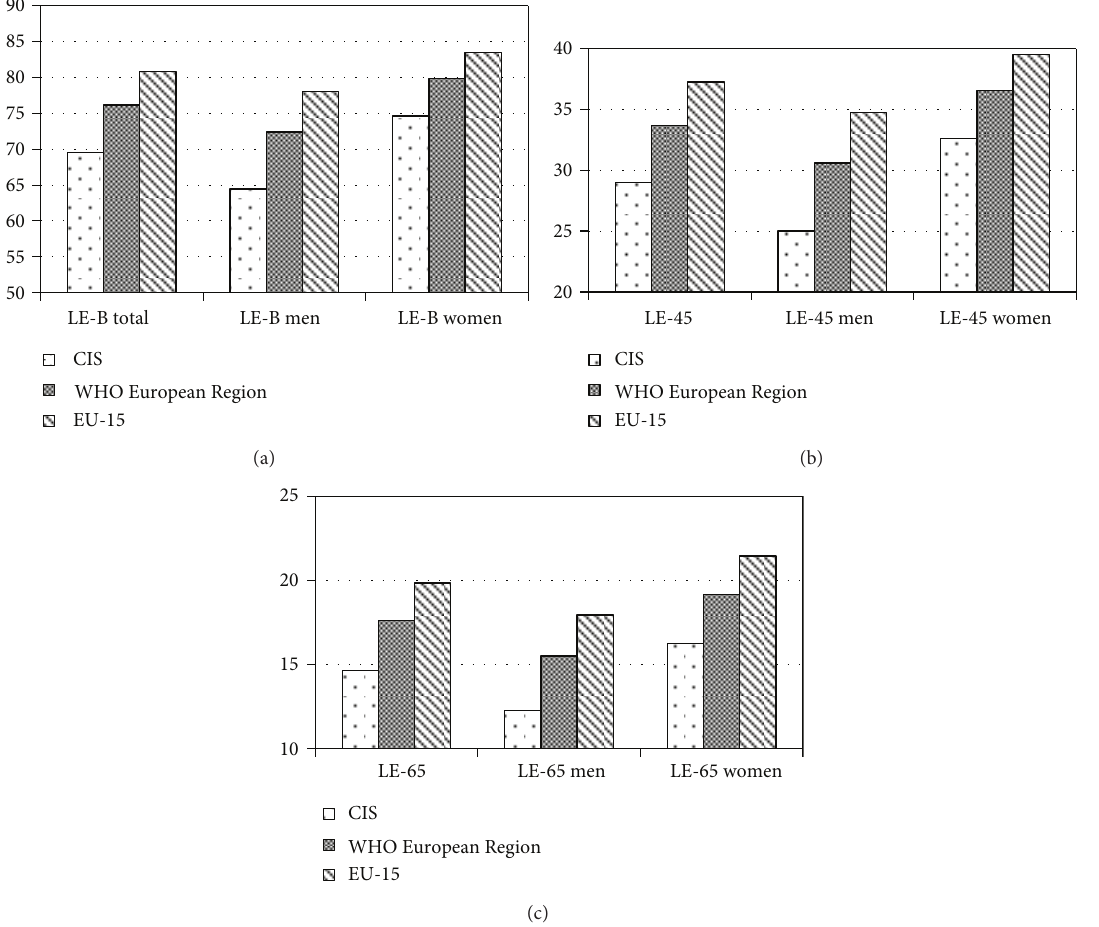
F6:Lifeexpectancyatbirth(a)45yearsofage(b)and65yearsofage(c)2008-2009(Source:WHORegionalOfficeforEurope,European health for all database (HFA-DB) (http://data.euro.who.int/hfadb/shell_en.html). Note: the European region of WHO includes 53 countries: all European countries, all CIS countries, and also Israel and Turkey (http://www.who.int/about/regions/euro/en/index.html). EU-15 bloc of countries are: Austria, Belgium, Denmark, Finland, France, Germany, Great Britain, Greece, Ireland, Italy, Luxembourg, the Netherlands, Portugal, Spain, and